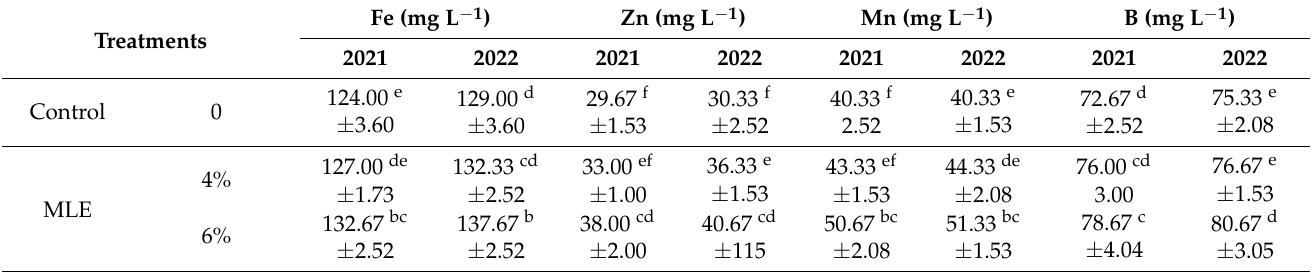
Table 8. The influence of the spraying of MLE, SWE and FA and their combinations on leaf Fe,